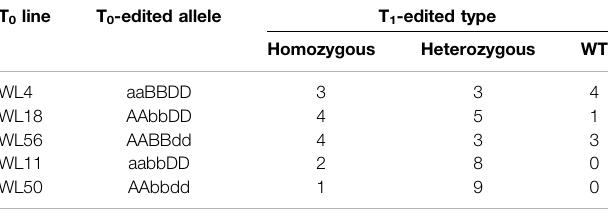
TABLE 2 | Summary of mutations in the TaNud genes in T 1 -edited wheat plants.